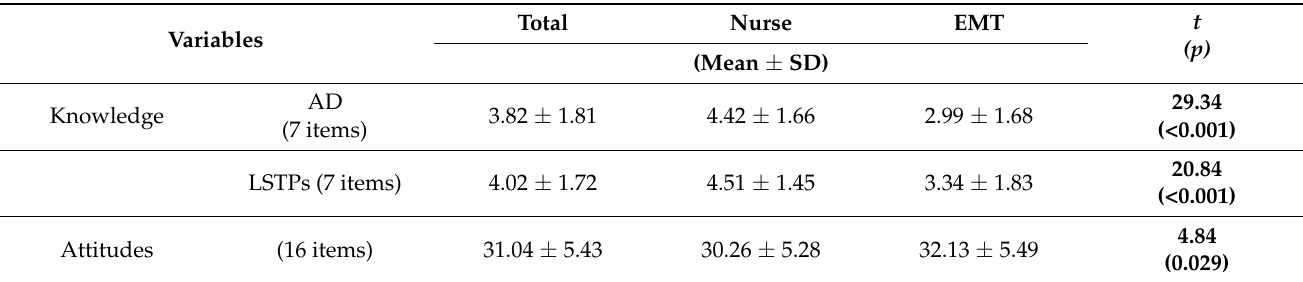
attitudes toward the ADs, with EMTs having more positive attitudes than nurses (32.13 vs. 30.26, p = 0.029). Table 3. Differences in knowledge about and attitudes toward ADs between nurses and emergency medical technicians ( n =